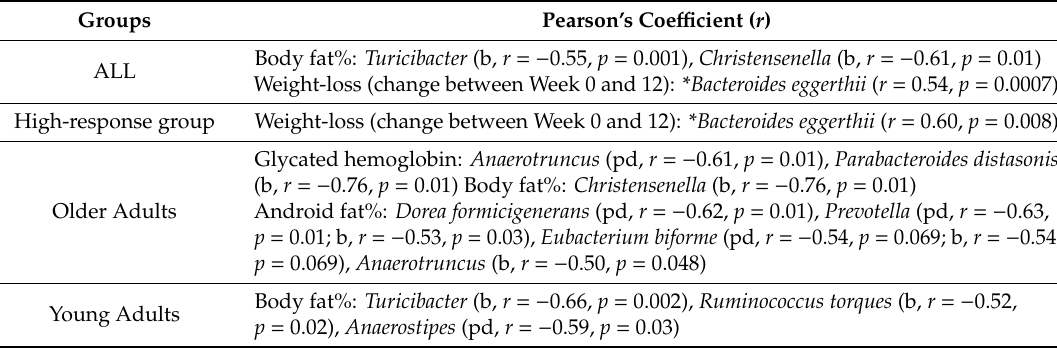
Table 7. Correlations among bacteria and participant